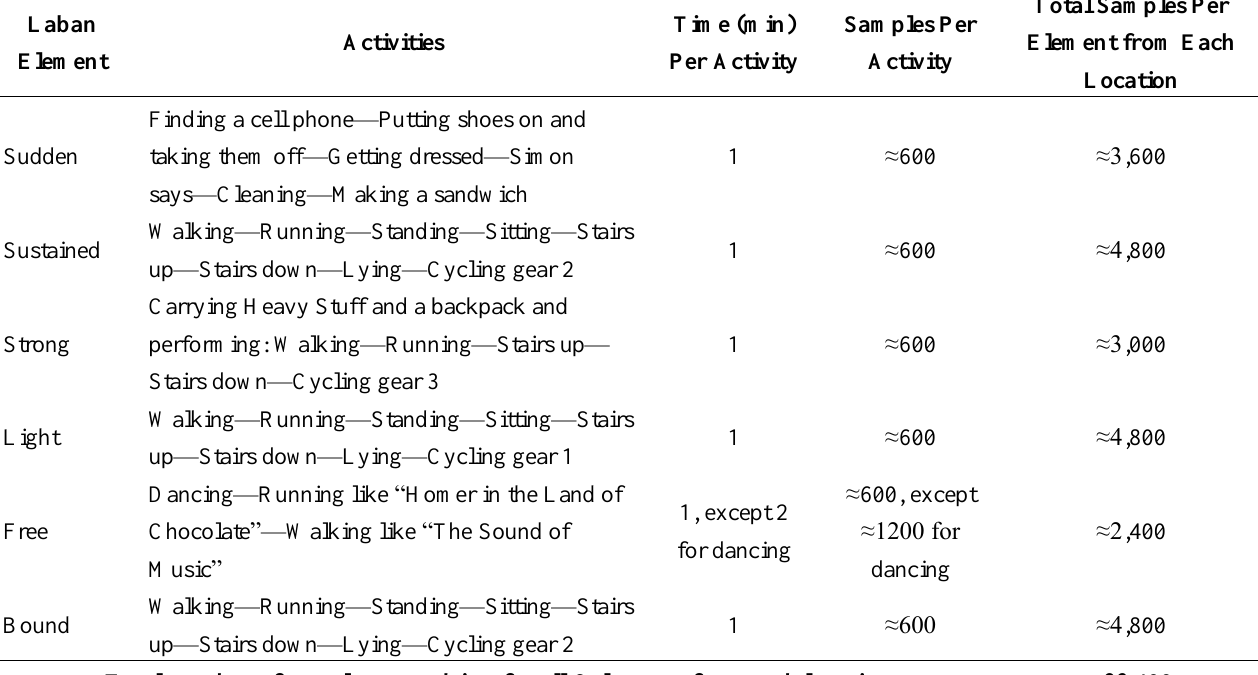
Table 2. Activities performed by each